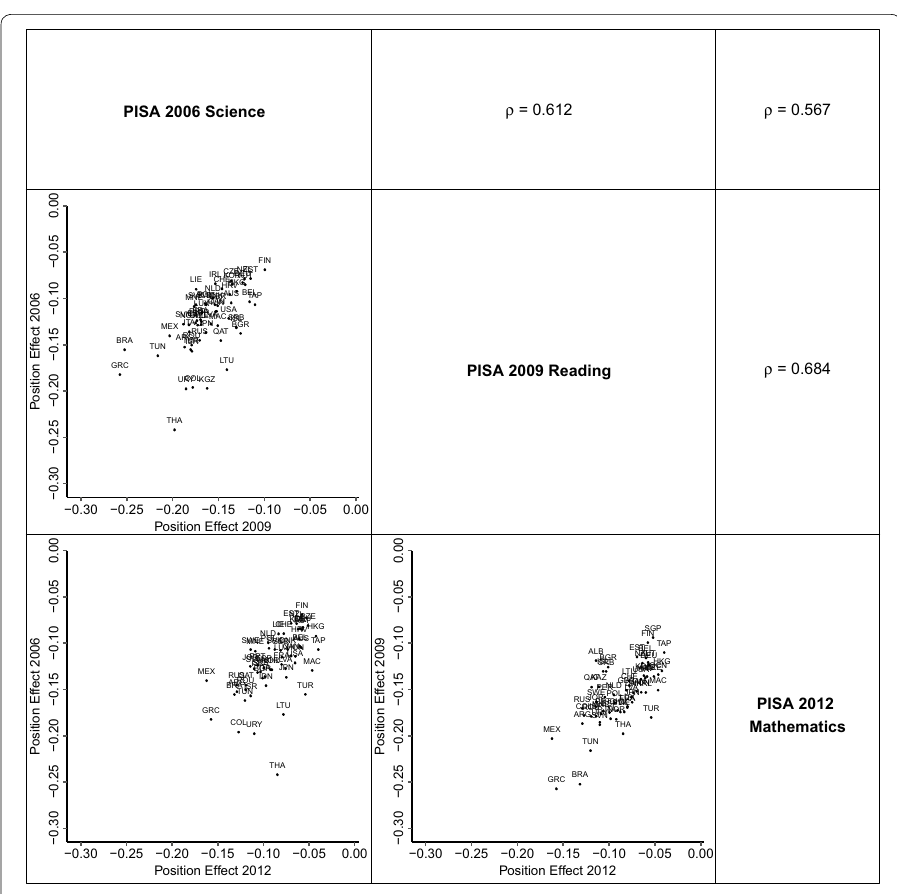
Fig. 2 The scatter plots and the correlations of cluster position effects of all countries across the three PISA